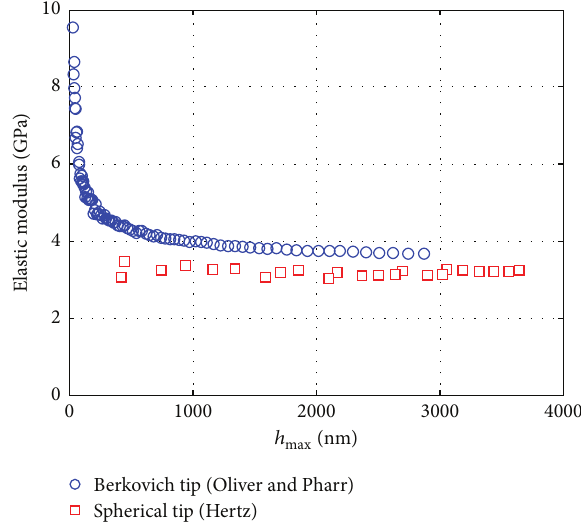
Figure 27: Elastic modulus of epoxy [25] determined with a Berkovich tip, 𝐸 O&P , (using Oliver and Pharr method [53] with 20 s loading, holding, and unloading times) and with a spherical tip, 𝐸 Hertz , (using Hertz theory with 20 s loading time).